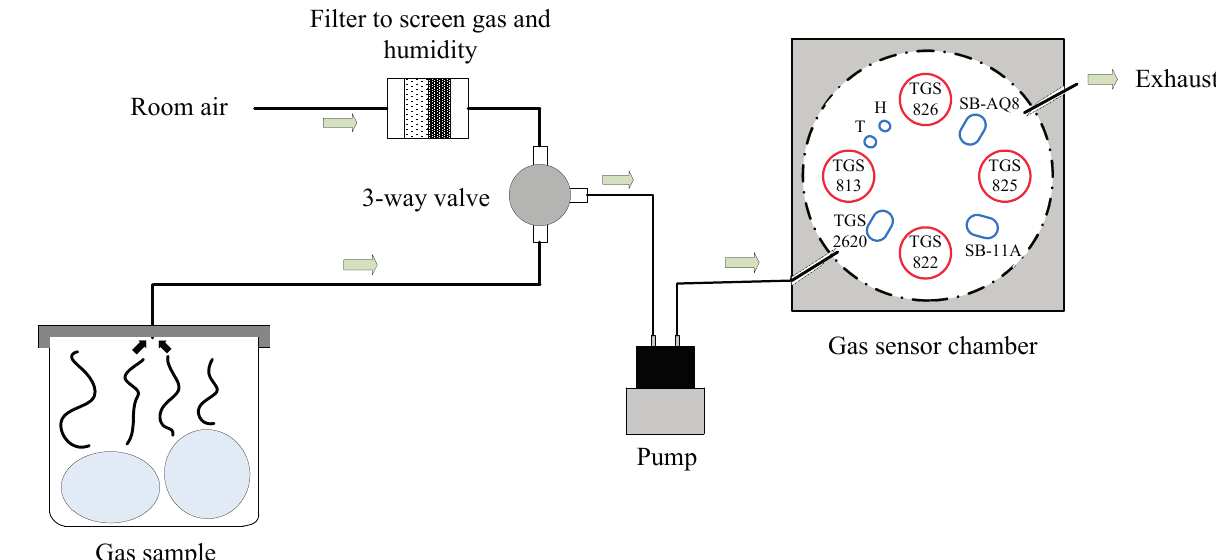
Figure 2. Schematic diagram of the mechanical design of the customized gas sensor array and two air flow